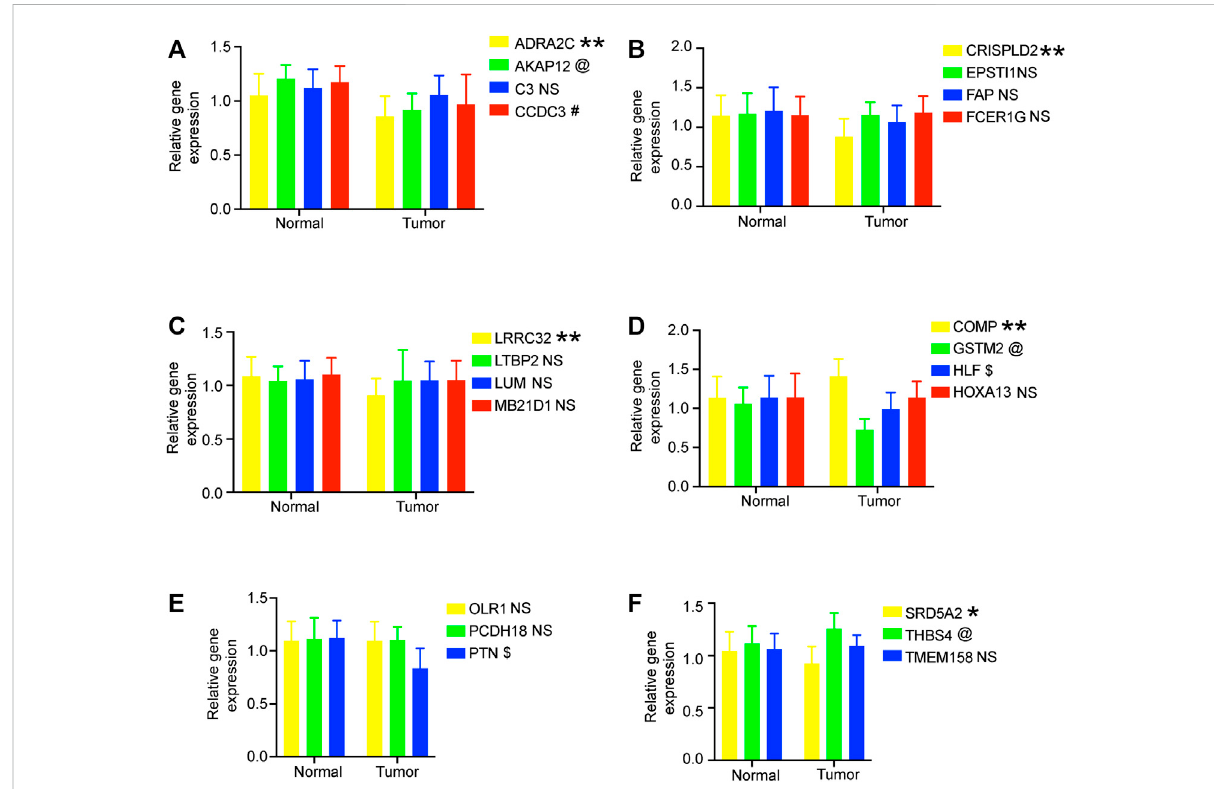
FIGURE 7 RT-PCRveri fi edtheexpressionofgenesin20pairsofprostatecancerclinicalsamples. (A – F) Relativegeneexpressionlevelinthenormalgroup and tumor group. All data are displayed as means ± SD; mean values for the normal group were normalized to 1.0; NS, no signi fi cant difference vs. normal group; ** p < 0.01 and * p < 0.05 vs. normal group. @* p < 0.05 vs. normal group. # * p < 0.05 vs. normal group. $* p < 0.05 vs. normal